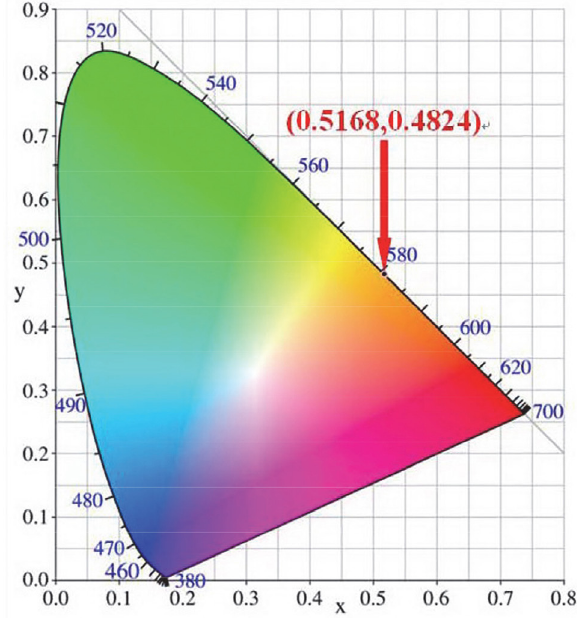
Figure 5. A CIE figure of compound 1 .